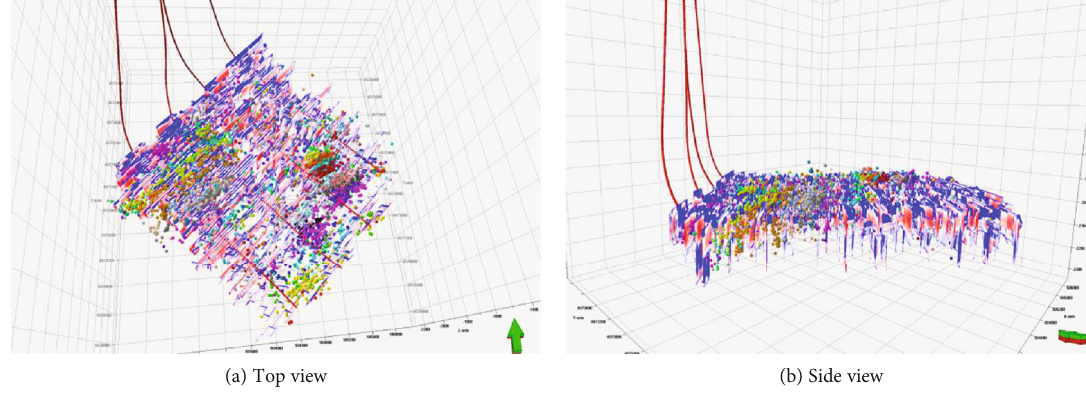
Figure 14: Fracture simulation results of the pad.